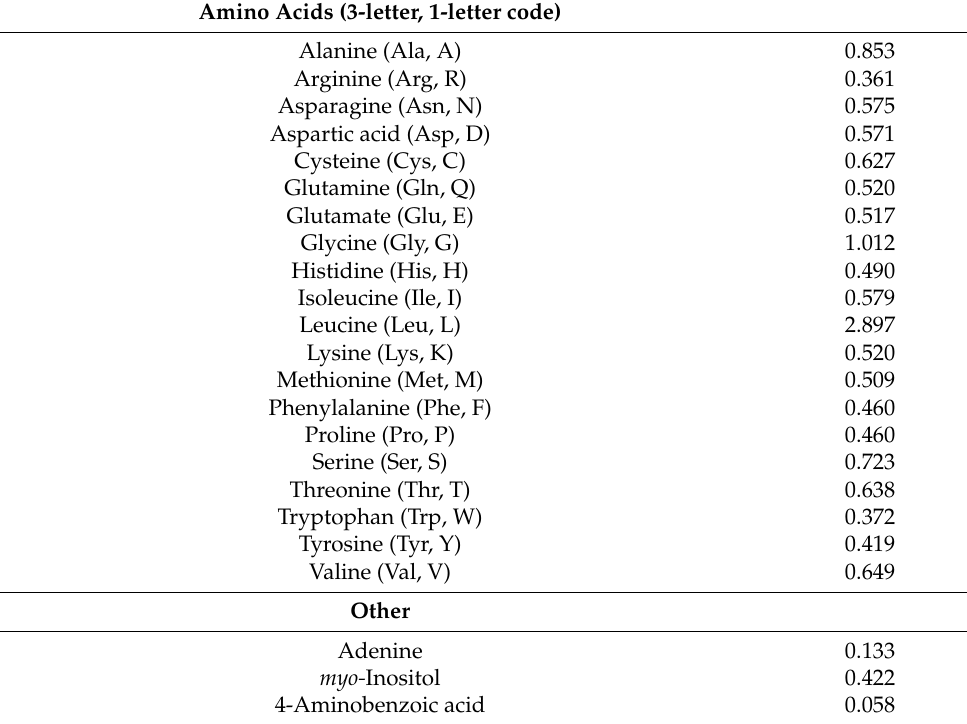
Table 4. Concentration (mM) of components in synthetic complete (SC) mixture, when used at 1x. Amino Acids (3-letter, 1-letter code) Alanine (Ala,